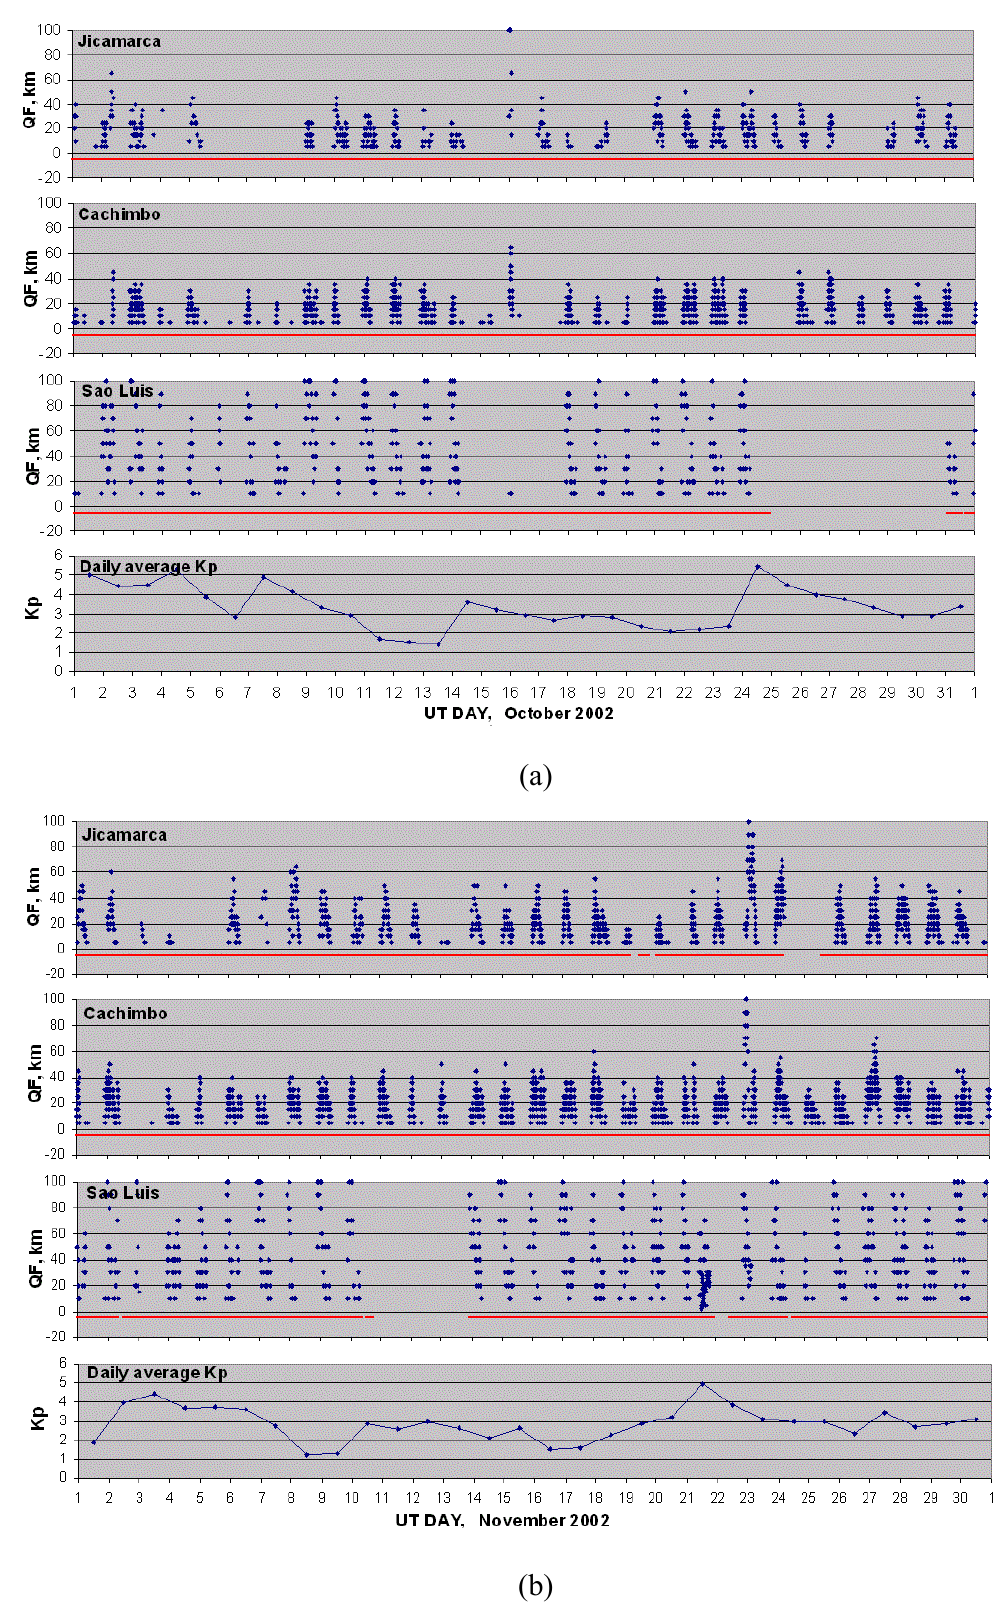
Fig. 8. Automatically detected range spread at Jicamarca, Cachimbo, and Sao Luis for ( a ) October and ( b ) November 2003. Underlining shows the times of digisonde operation.